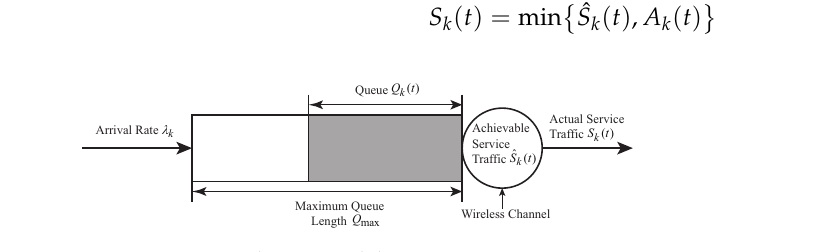
Figure 2. Queue theory model.